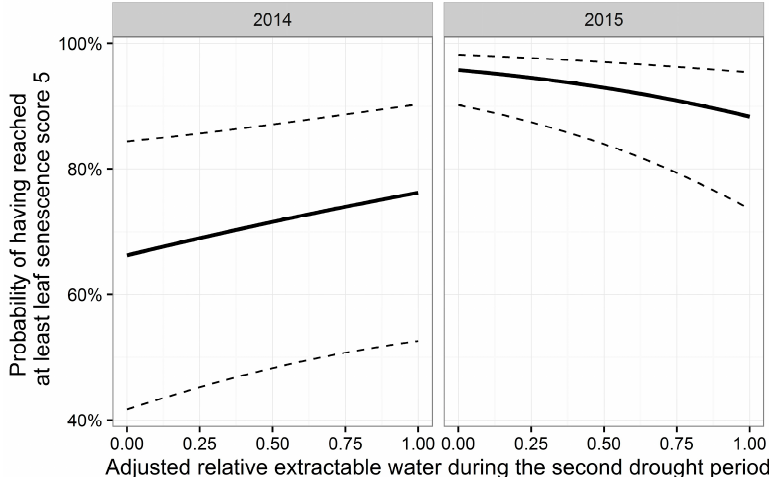
Figure 2. Modelled probability of having reached at least leaf senescence score 5 (yellowing leaves with brown parts) depending on the adjusted relative extractable water of the pots during the second drought period in the first growing season. To calculate the probabilities, the mean plant height of 9.2 cm in 2014 and of 17.6 cm in 2015 was applied, together with DOY 2014 = 340 and DOY 2015 = 325; 95% confidence intervals are shown with dashed lines. Table 3. Model statistics for the general linear mixed models of the ordinal phenological response variables leaf senescence and bud burst.